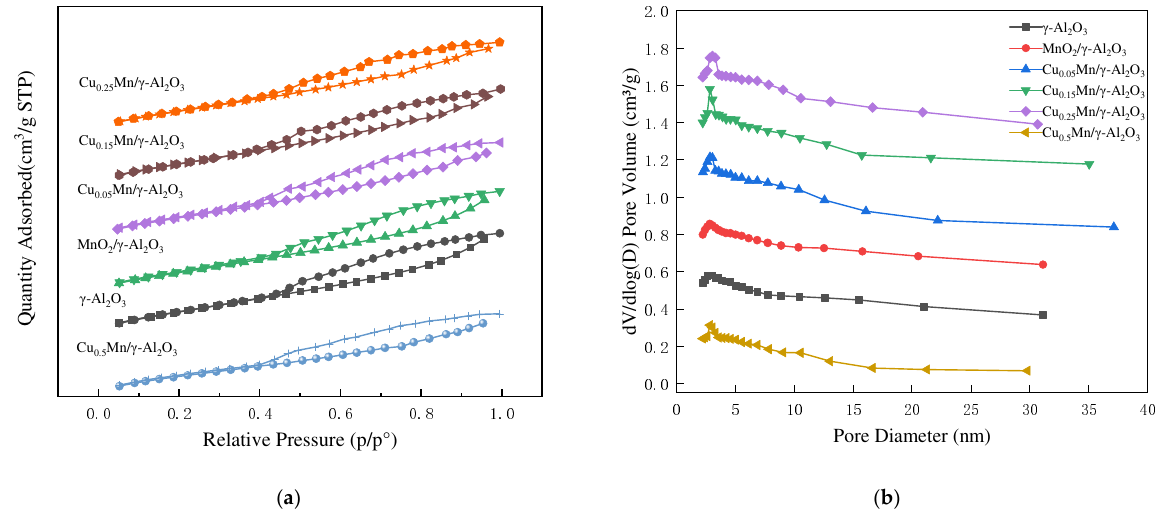
Figure 3. BET characterization analysis diagram of Cu-doped MnO 2 catalysts. ( a ) N 2 adsorption- desorption isotherm of the catalysts, ( b ) pore size distribution measurement diagrams. Table 1. Comparison of specific surface area, average pore diameter, and pore volume of different catalysts.